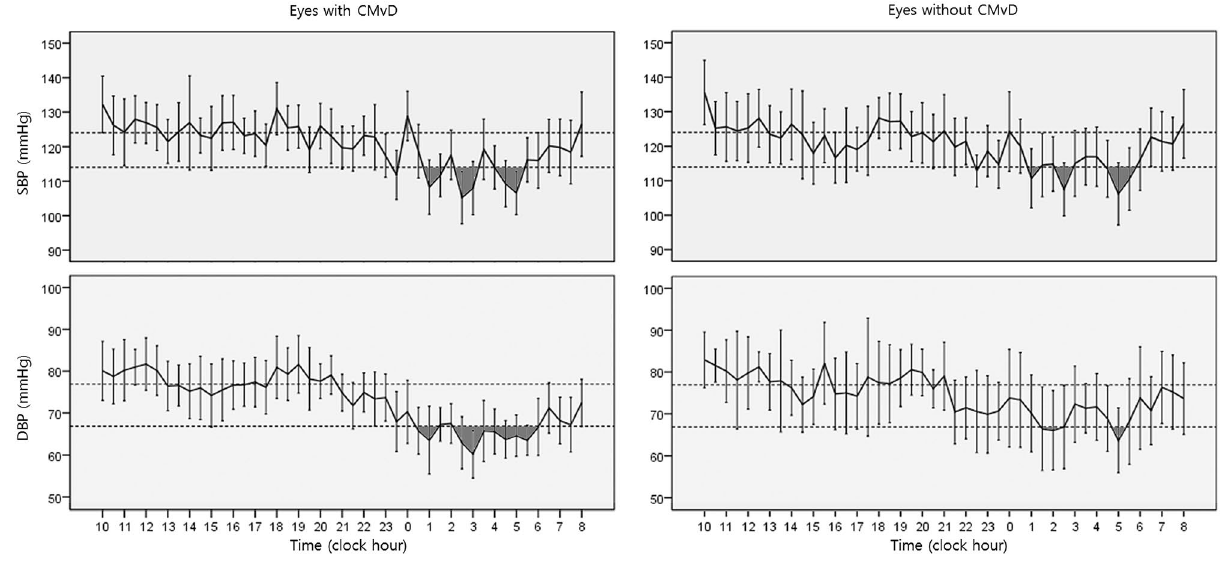
Figure 1. Overall 24-h blood pressure (BP) patterns of eyes with and without choroidal microvasculature dropout (CMvD) in the entire patient group (n = 88). Nighttime diastolic BP (DBP) in eyes with CMvD showed a longer duration and greater magnitude of BP dip (black area; at least 10 mmHg below the mean daytime BP) than those in eyes without CMvD. However, nighttime systolic BP (SBP) did not show differences in patterns of duration and magnitude of BP dip between eyes with and without